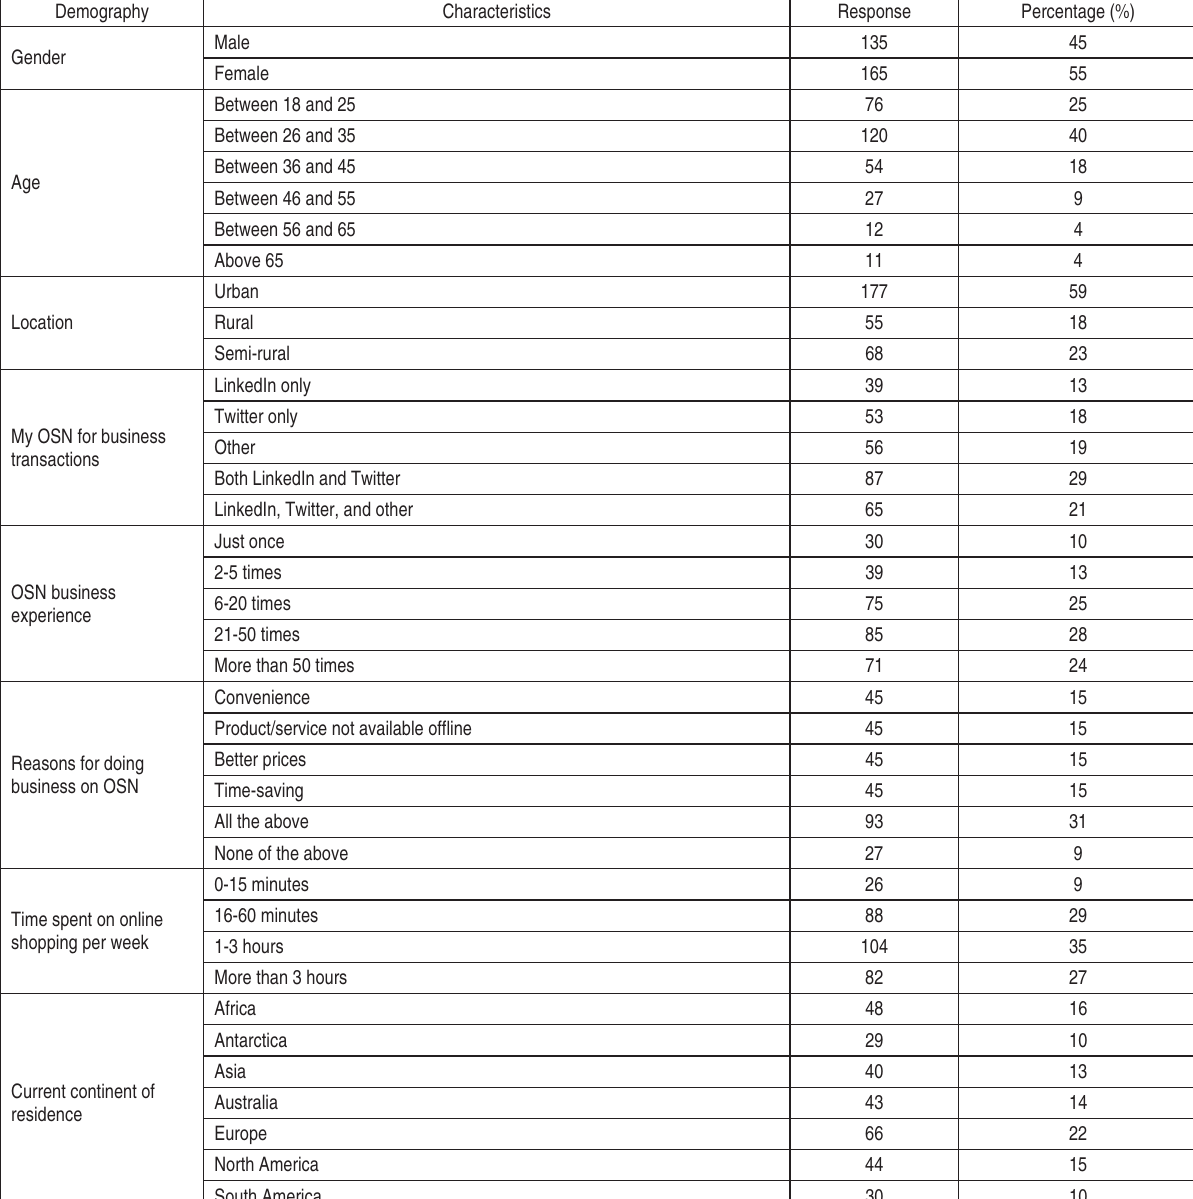
Table 1. Descriptive statistics of respondent